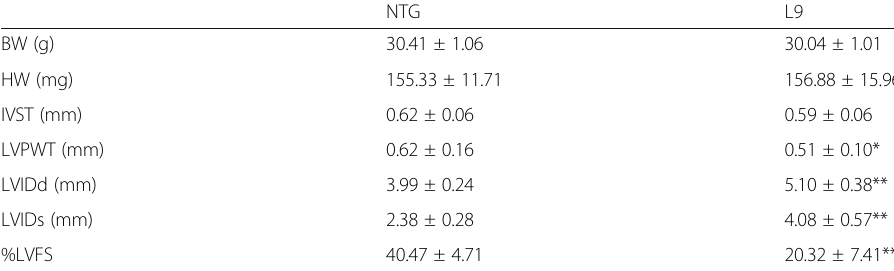
Table 1 Echocardiographic data for α MHC/miR-143/145TG (L9)